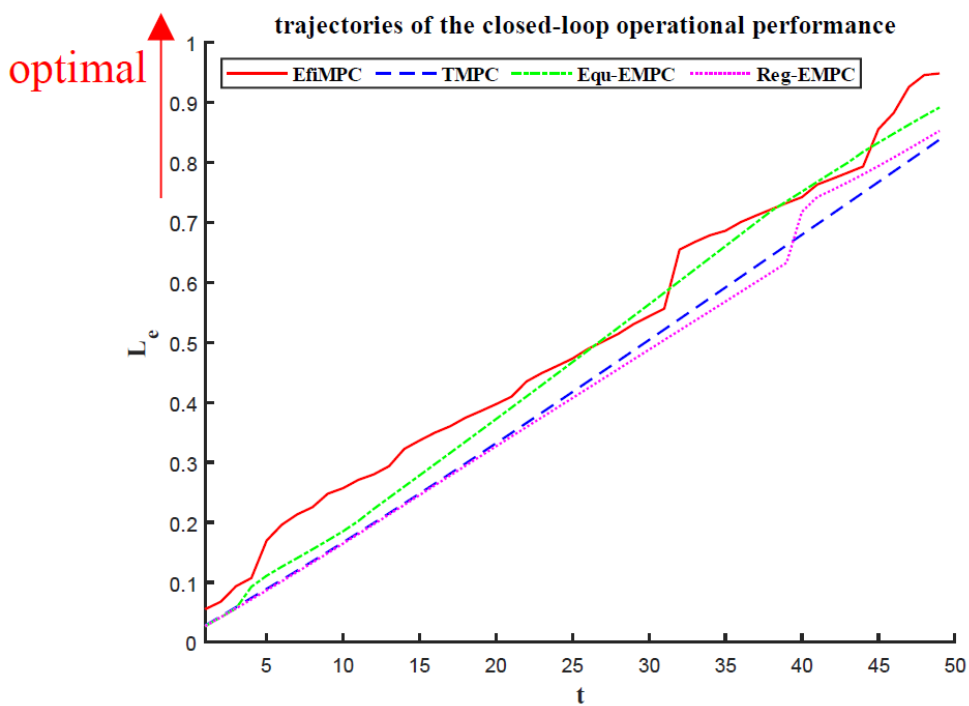
Figure 6. The closed-loop operational performance of the comparative control strategies. Table 1. The closed-loop operation performance of the comparative control strategies.